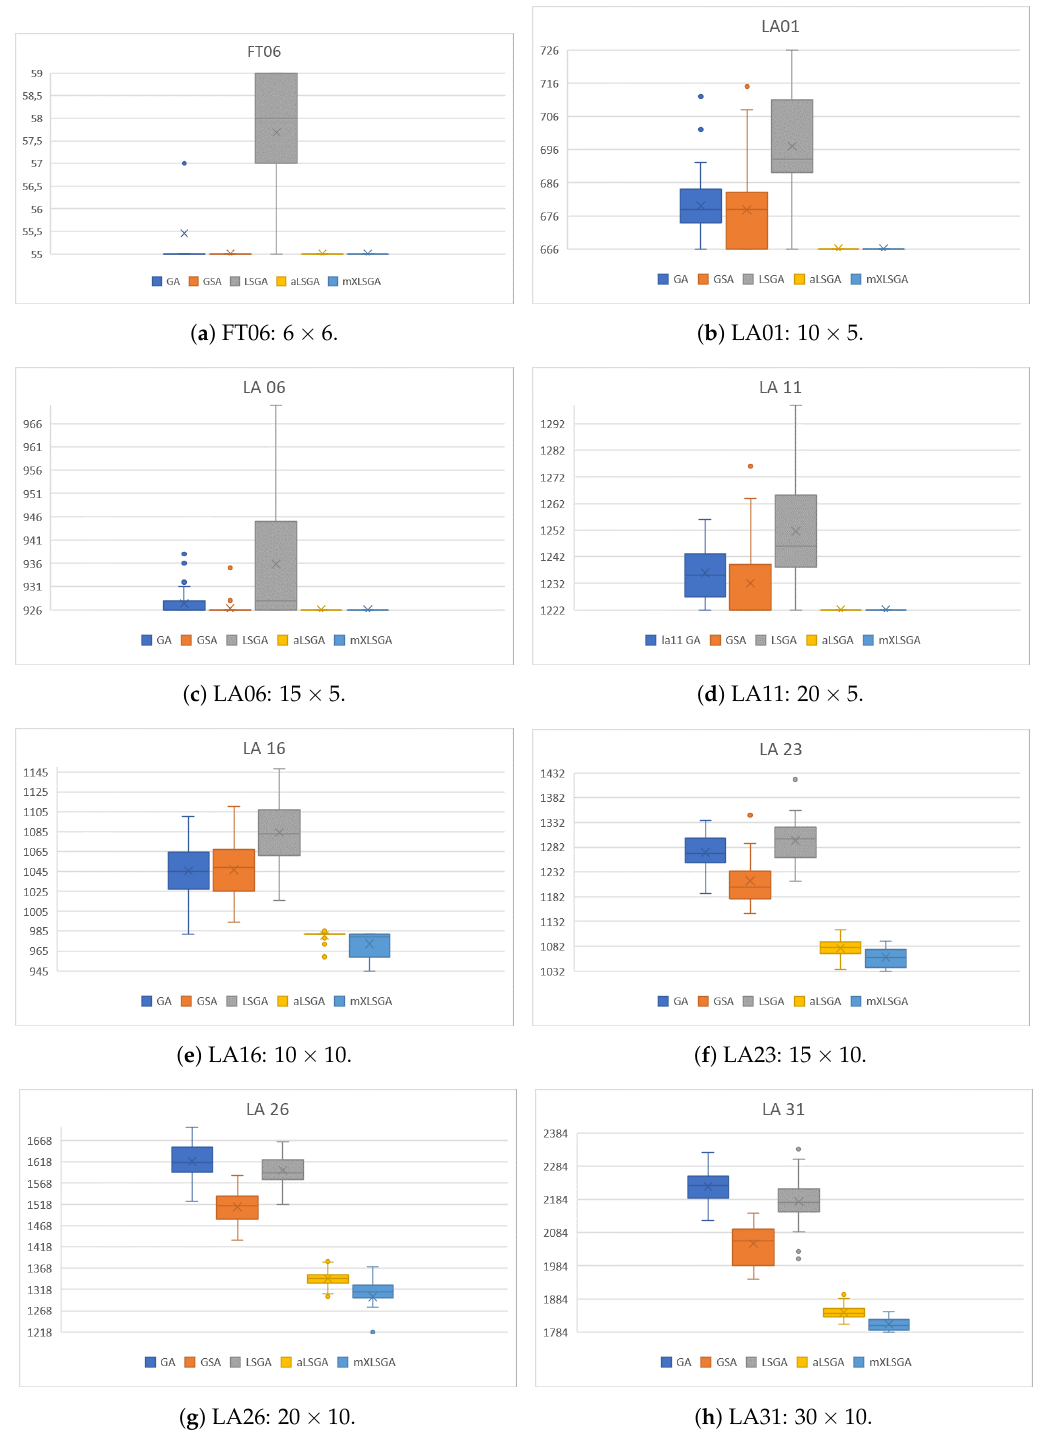
Figure 6. Box plots of the fitness values of 35 executions of the GA-Like